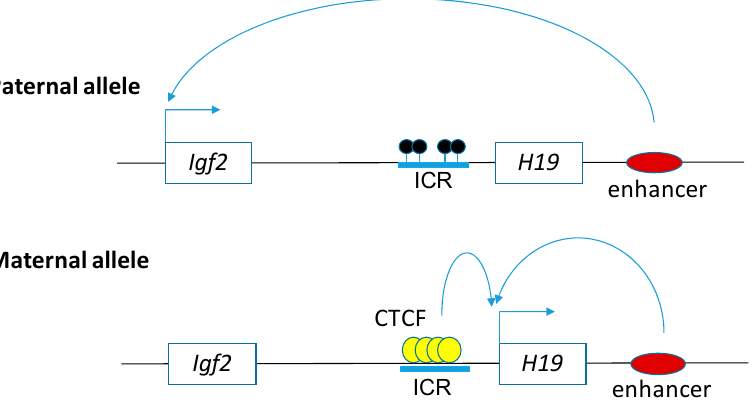
Figure 1. The epigenetic state of imprinting control region on the Igf2 - H19 locus determines the expression pattern. Regulation of maternal and paternal expression in the Igf2 - H19 imprinted domain is controlled by genomic DNA methylation. The open boxes represent the genes Igf2 and H19 , and the blue boxes represent the imprinting control region (ICR). The close lollipops represent methylated CpG islands. The yellow and red circles represent the CCCTC binding factor (CTCF) insulator protein and enhancer, respectively. The arrows from the boxes indicate expression of the genes. Igf2 and H19 genes are activated by the shared downstream enhancer, and their activations are dependent on the DNA methylation of the ICR. CCCTC binding factor (CTCF) is recruited to unmethylated ICR on the maternal allele that promotes the enhancer to activate the expression of H19 gene, but not of Igf2 gene. In contract, on paternal allele, ICR is hypermethylated that prevents the binding of CTCF to ICR. The overall outcomes are that the expression of H19 is repressed, but the expression of Igf2 is induced, from the paternal allele.